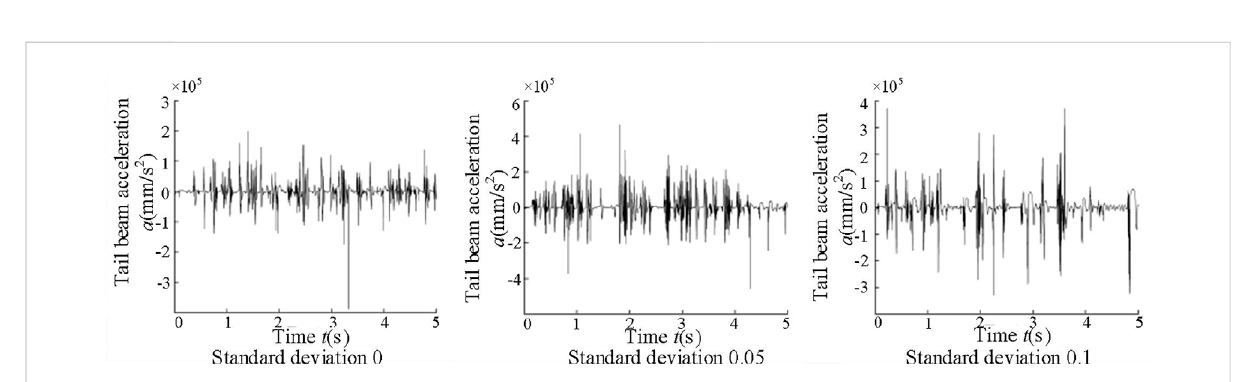
FIGURE 15 Time-domain diagram of tail beam vibration under different particle distributions.